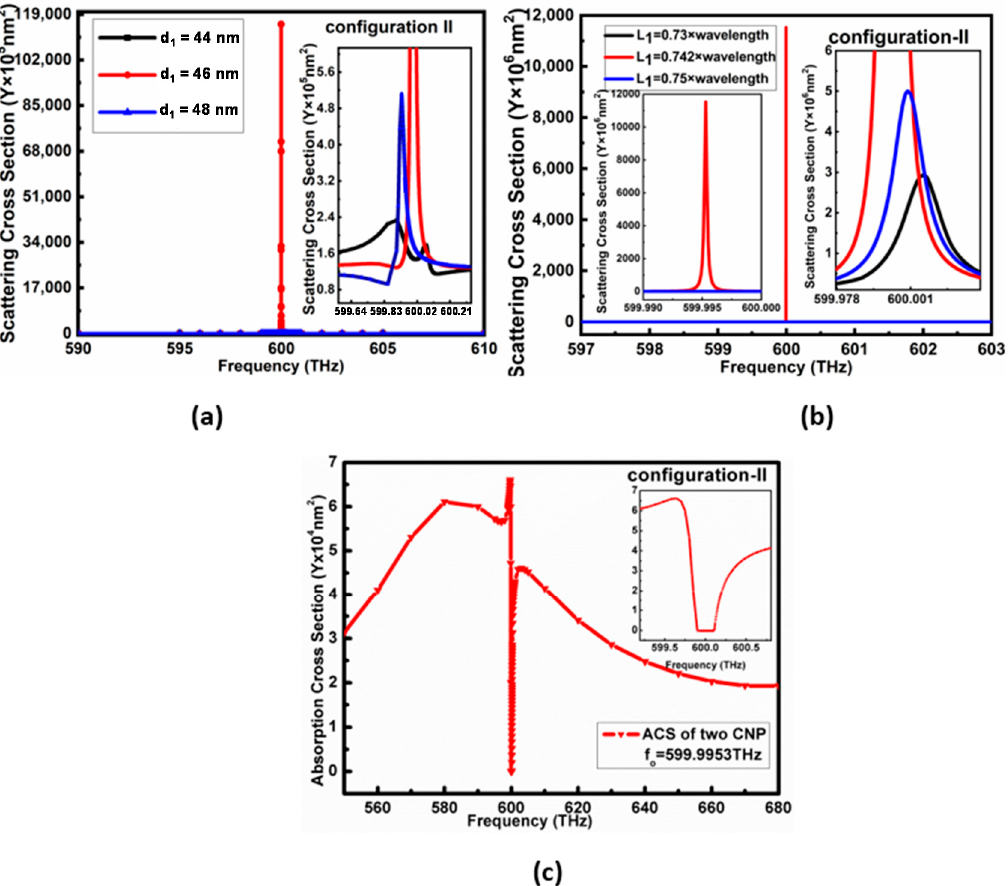
Figure 4. shows optimization results for configuration 2. ( a ) shows optimization peaks of d 1 , ( b ) denotes the optimiza- tion of L 1 for configuration-II; here, SCS 11.53 × 10 9 nm 2 peaks shown by black, red and blue line represent SCS for L 1 = 0.73 λ nm, L 1 = 0.742 λ nm, and L 1 = 0.75 λ nm passive spacing, respectively. ( c ) shows ACS (6.5 × 10 4 nm 2 ) for configuration-II.